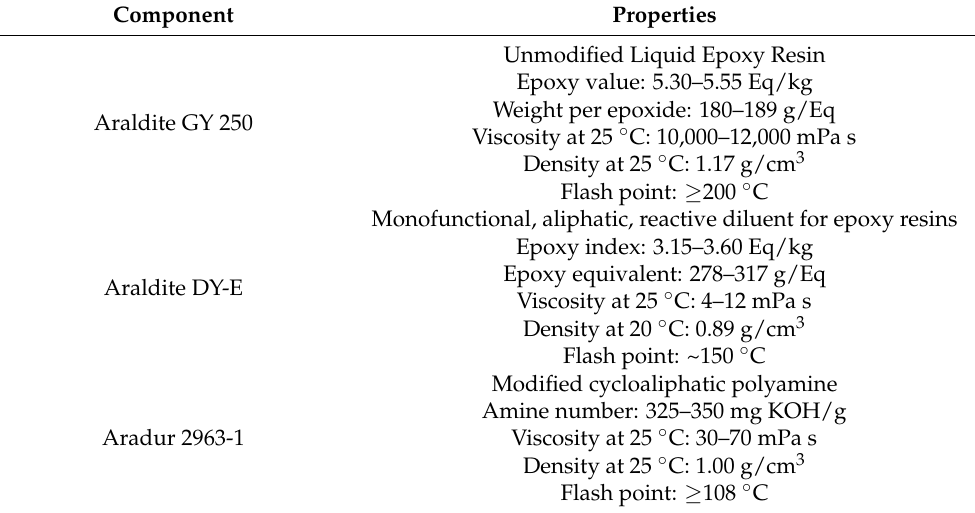
Table 1. The main properties of epoxy resin and hardener [34–36].